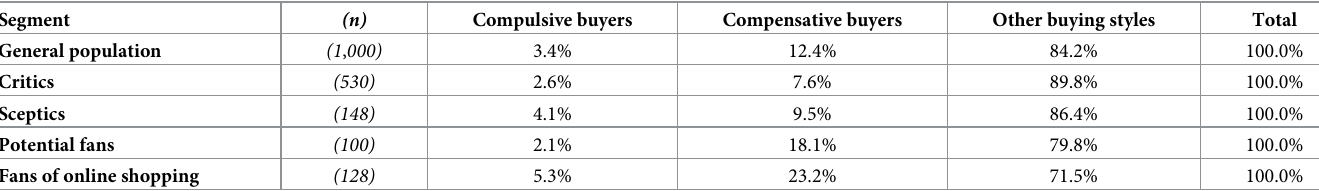
Table 4. Compulsive and compensative buyers by attitudes towards online